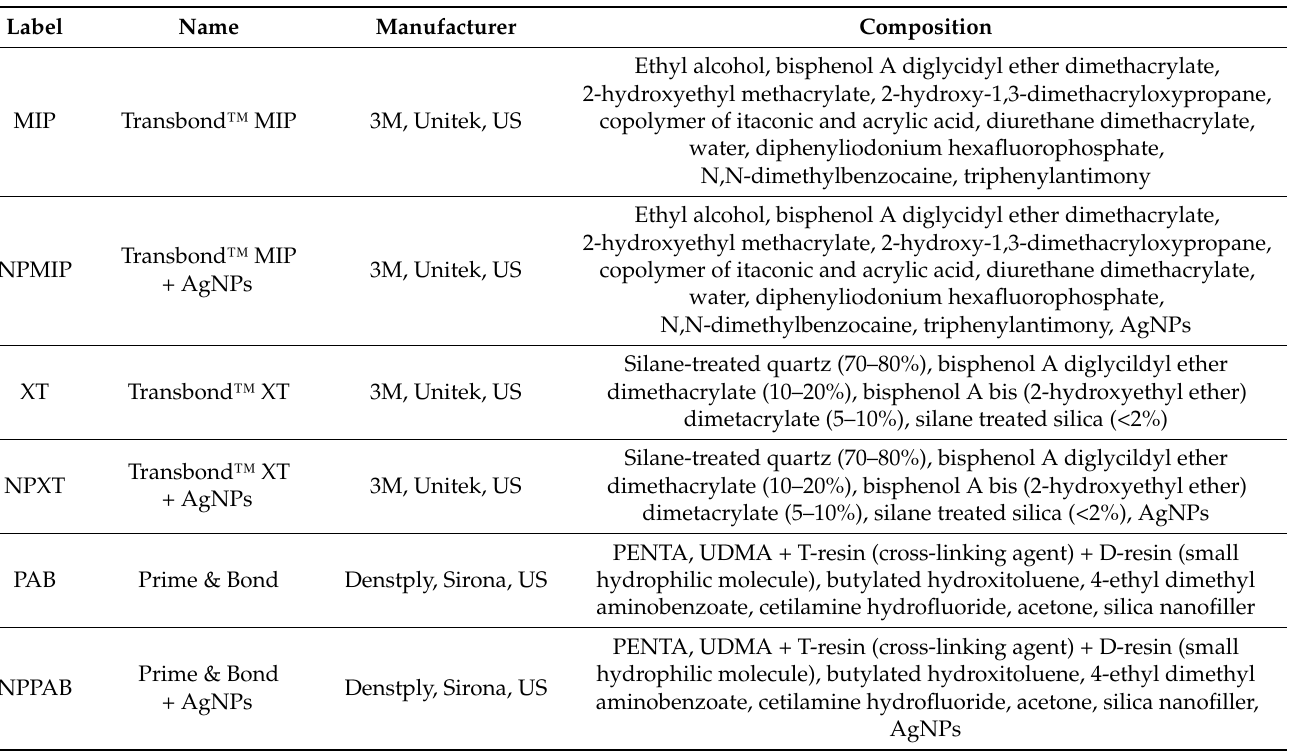
Table 5. Composition of the adhesives used in this